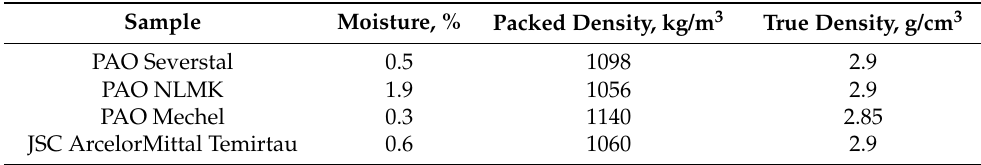
Table 2. Moisture and density of granulated blast furnace slags from the calibration set.